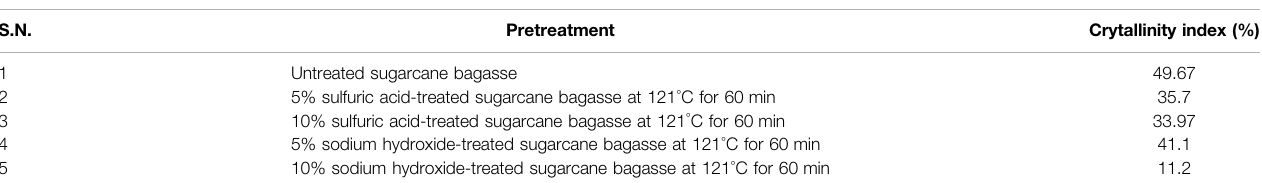
TABLE 2 | Crystallinity index of untreated, acid-, and alkali-pretreated sugarcane bagasse.